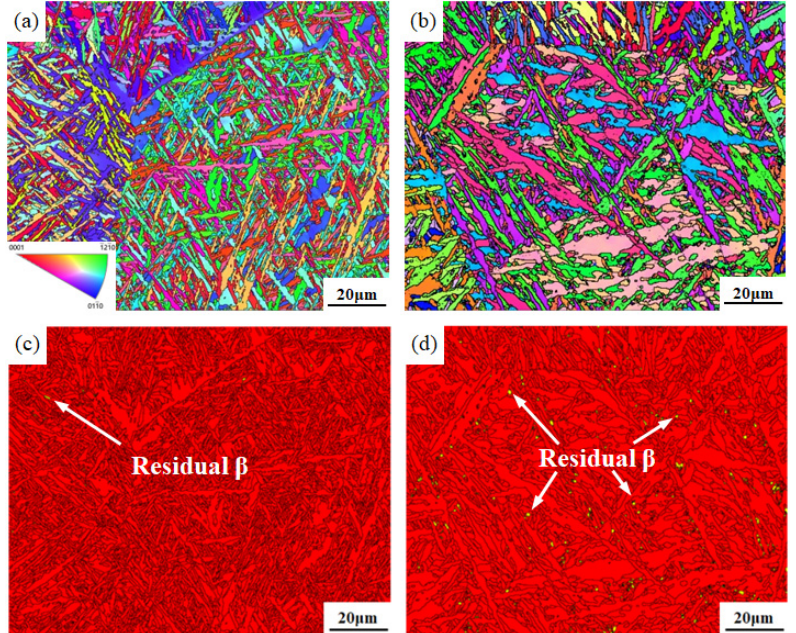
Figure 10. Comparison of the IPF and phase distribution of the welding joints: ( a , b ) IPF for flux-cored wire and cable wire welding joints; ( c , d ) phase distribution for flux-cored wire and cable wire welding joints.